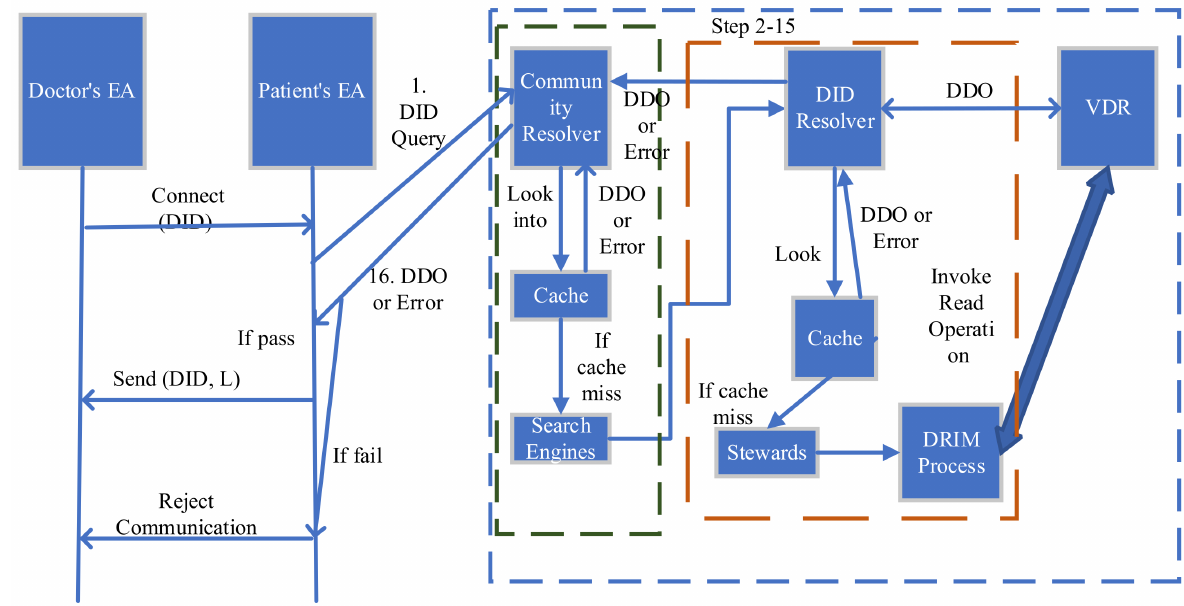
Figure 4. Authentication